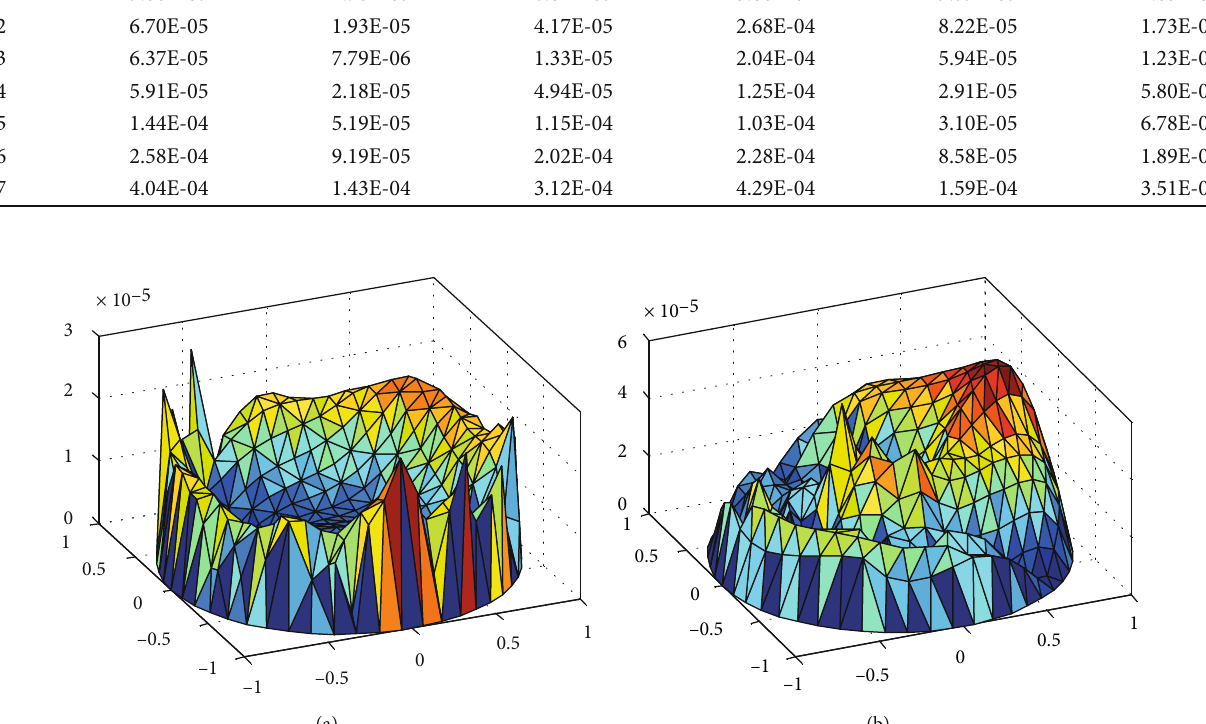
= 10 . Uniform (a) and circular (b). Example 1 using Dirichlet t